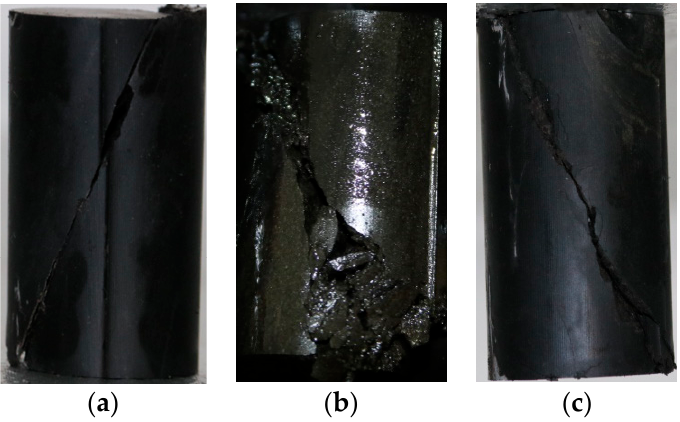
Figure 14. Damage diagram under a 14 MPa confining pressure: ( a ) moisture content: 0%; ( b ) moisture content: 1.06%; and ( c ) moisture content: 1.40%.